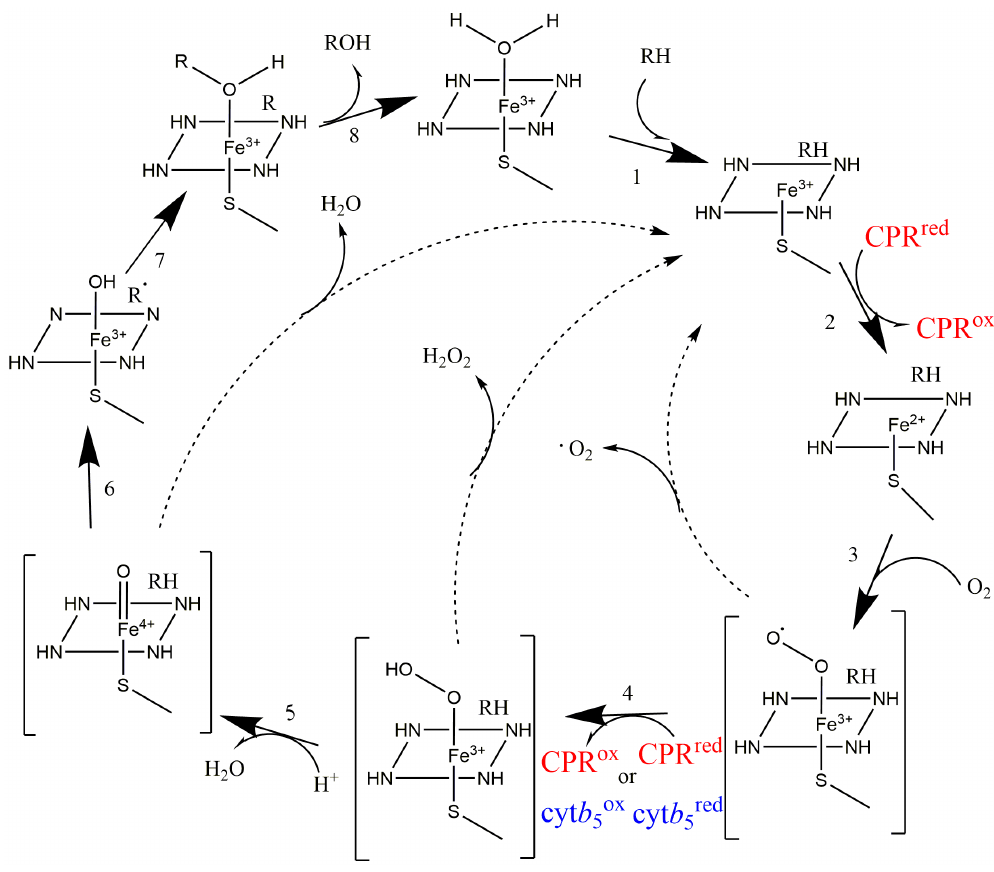
Figure 1. The catalytic cycle of cytochrome P450. The binding of substrate R-H (1) causes a decrease of the redox potential of about 100 mV, which allows the first electron transfer from cytochrome P450-reductase (CPR) (2). The reduction of Fe 3+ to Fe 2+ makes suitable O binding (3), which now can accept a second electron from either CPR or cytochrome b (cyt b ) (4), to form a hydroperoxyl intermediate 5 5 2 known as compound 0. The O 2−2 complex reacts with surrounding protons to form the highly reactive oxyferryl intermediate, also known as compound I (5). The Fe-ligated O atom (6) is transferred to the substrate forming a hydroxylated form of the substrate (7). The product is finally released (8), replaced by a molecule of water. Three uncoupling reactions are shown as dashed lines, with the respective products: the autoxidation shunt O 2−2 , the peroxide shunt (H O ), and the oxidase shunt (H 2 2 2